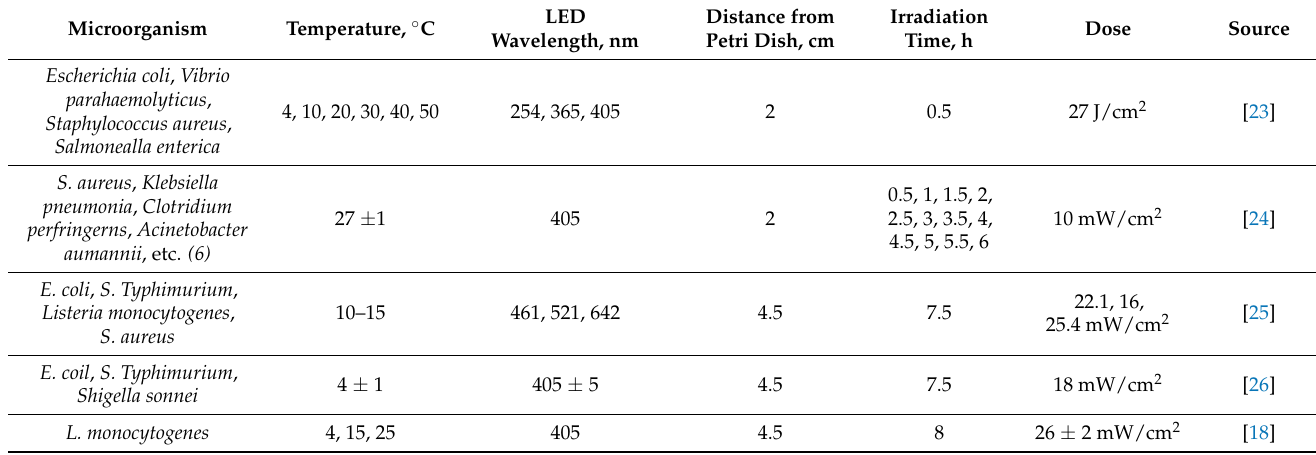
Table 1. Th experimental conditions in previous research [18,23–26].